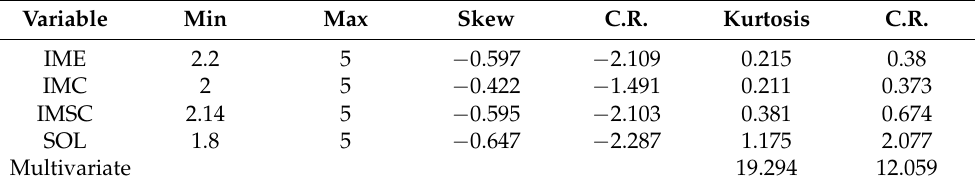
Table 5. Correlation analysis by AMOS.